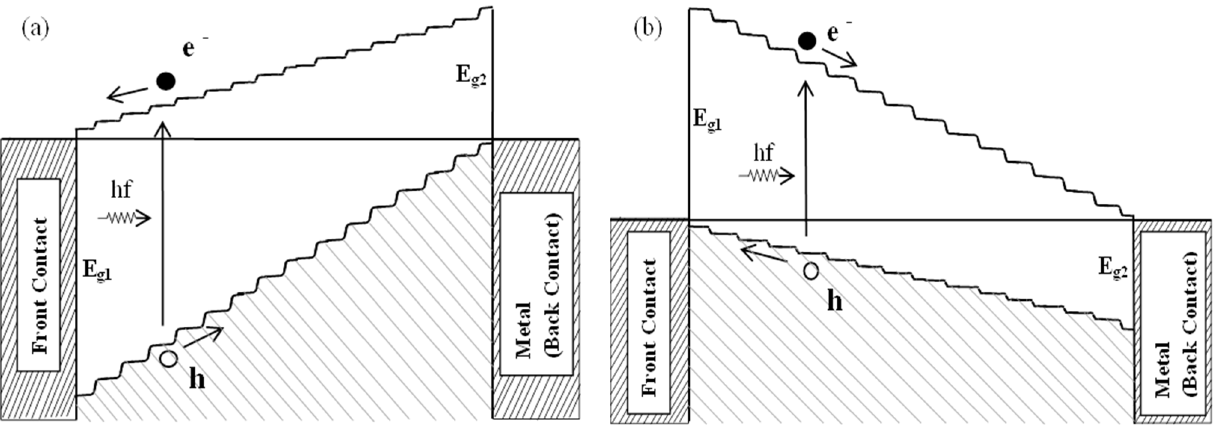
Figure 2. Energy band diagrams of graded bandgap devices based on ( a ) n-type